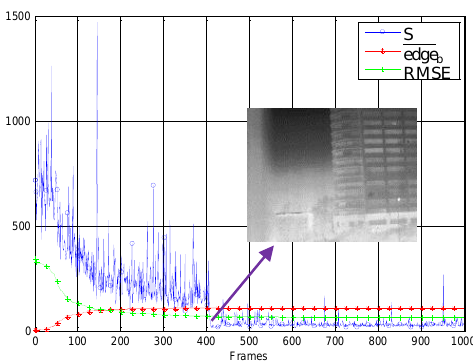
Figure 7. The variation of the important variables in our algorithm during the simulated nonuniformity data calibration.